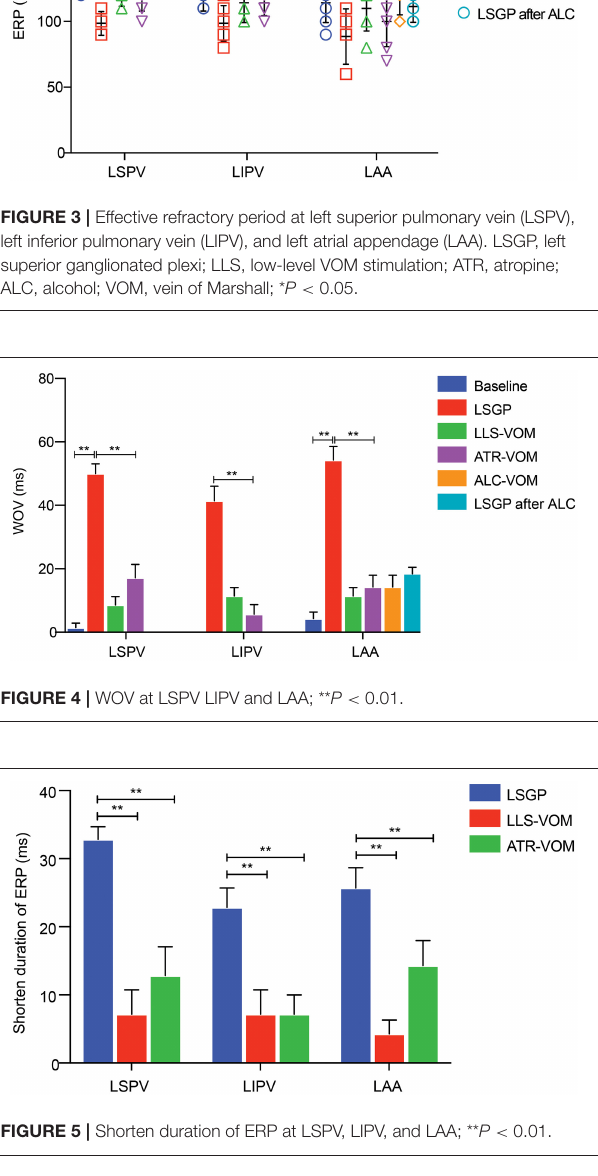
(11.4 ± 6.90 ms), and LAA (11.4 ± 6.90) were less prolonged with low-level stimulation in